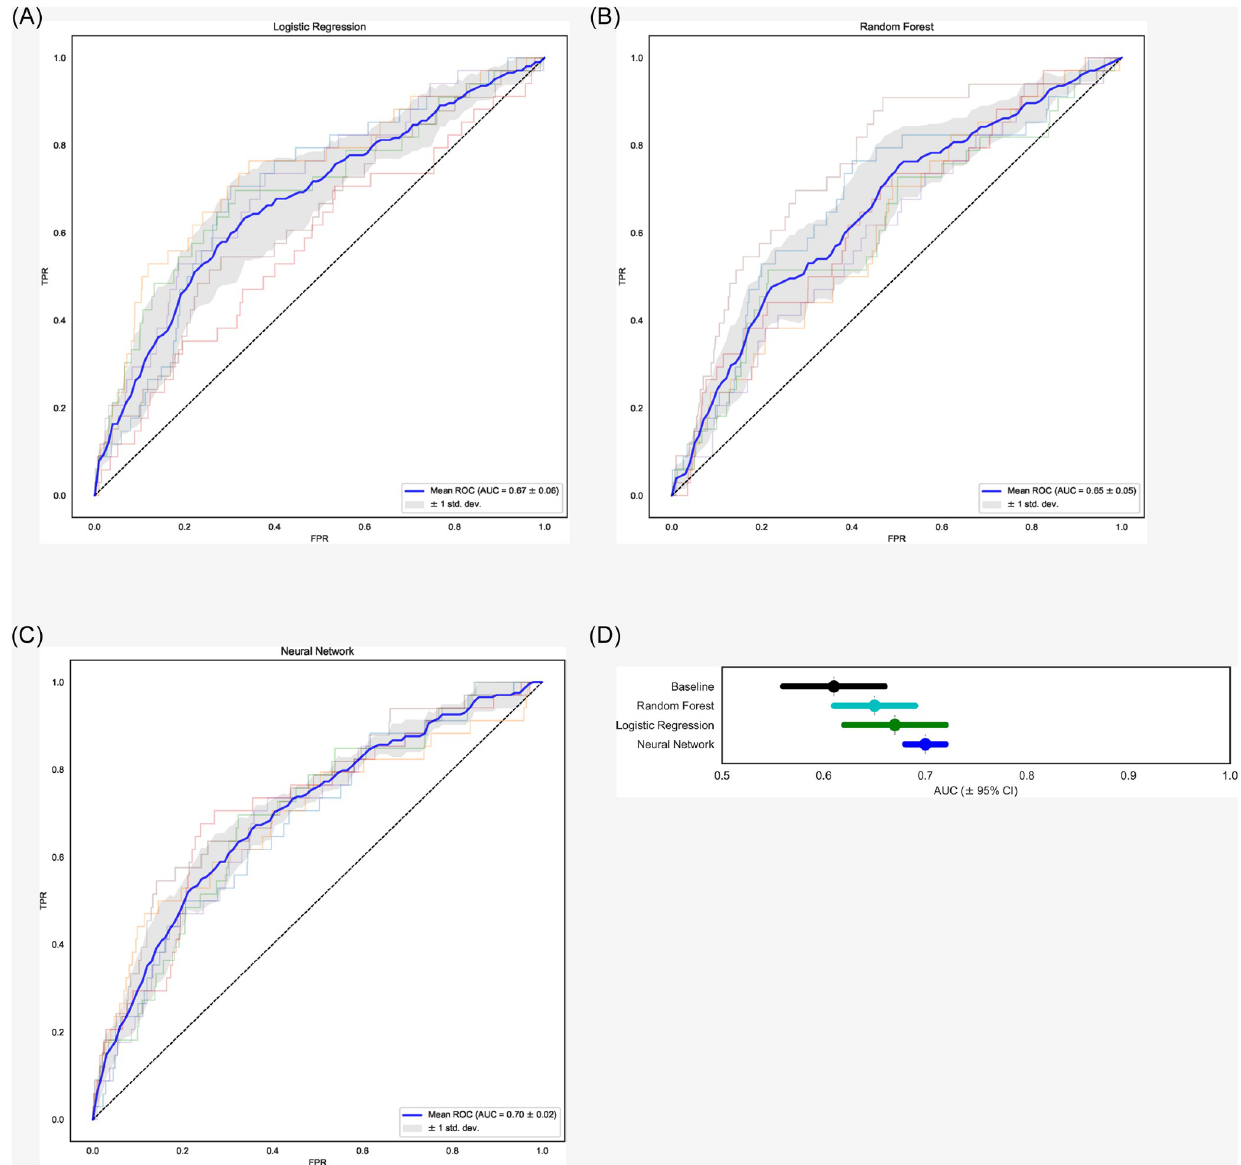
Fig 2. ROC curves for logistic regression (Panel A), random forest (Panel B) and neural network (Panel C) models over repeated, stratified, 3-fold cross- validation. Solid curve represents the mean ROC curve. AUC for each model were 0.67 ± 0.05, 0.65 ± 0.04, and 0.70 ± 0.02, respectively. Panel D is a plot of the AUC for each model ± 95% confidence